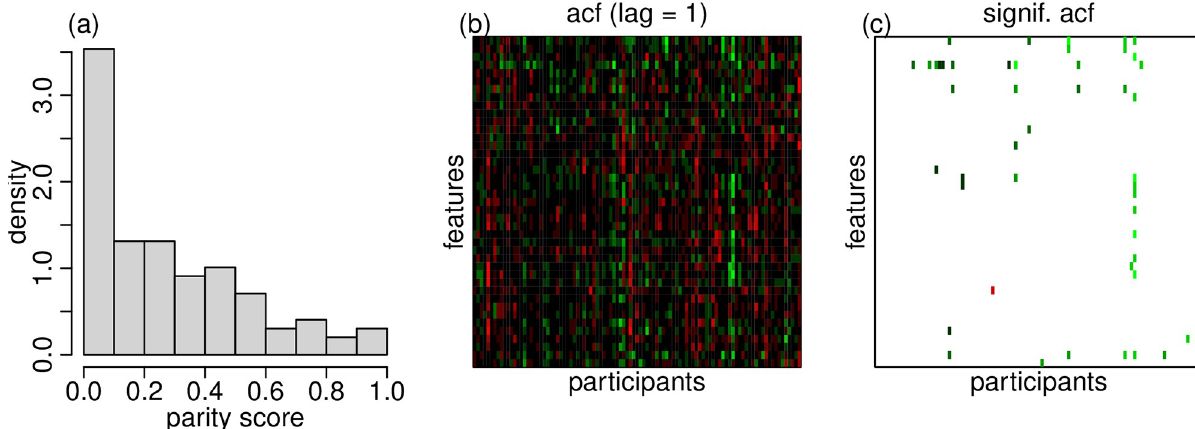
Fig 8. Panel a shows the distribution of the “parity score” across all participants. The parity score was defined as the proportion of days where the participant performed the tapping task before and after taking medication on the same day. Panel b shows a heatmap of the residual autocorrelation (lag = 1) of the linear regression model fits across all feature/participant combinations. Red and green represents, respectively, negative and positive autocorrelation. Panel c shows only the autocorrelation values that were statistically different from zero according to multiple testing corrected Ljung- Box tests at a significance threshold of 0.05. (The autocorrelation values that were not statistically significant are shown in white.) Only about 4.1% of the statistically significant autocorrelations were negative.